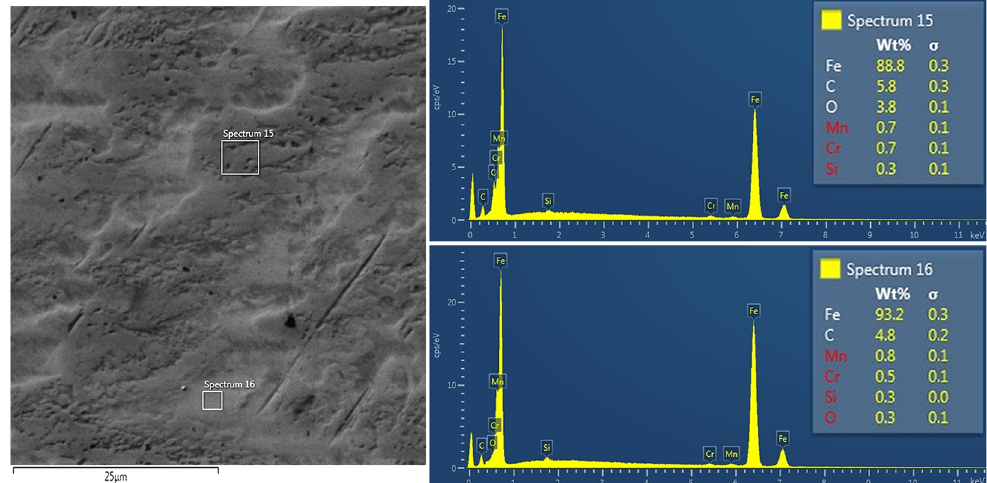
Figure 7. SEM and EDS analysis on the worn surface of AISI 8620 steel lubricated with canola oil.